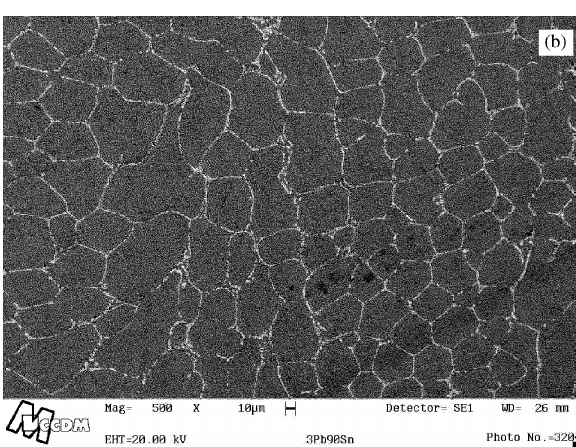
Figure 4. Microstructure of the Pb-90%Sn alloy. (a) Sample A, ∆ T 1 = 8 K; (b) Sample B,